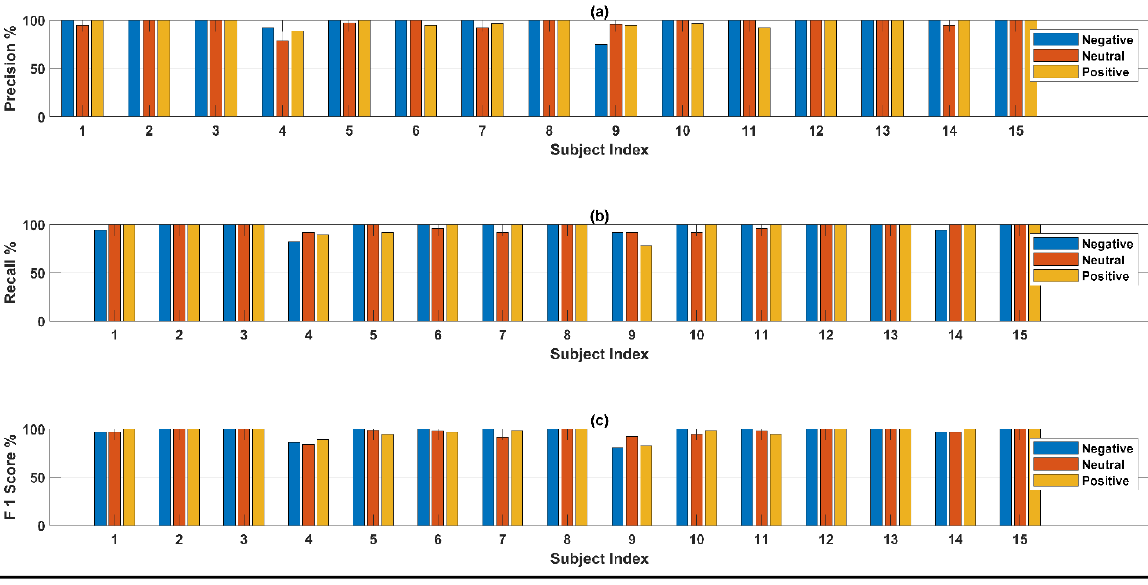
Figure 14. Observed ( a ) precision ( b ) recall and ( c ) F1 scores from the network considering all 62 channels.